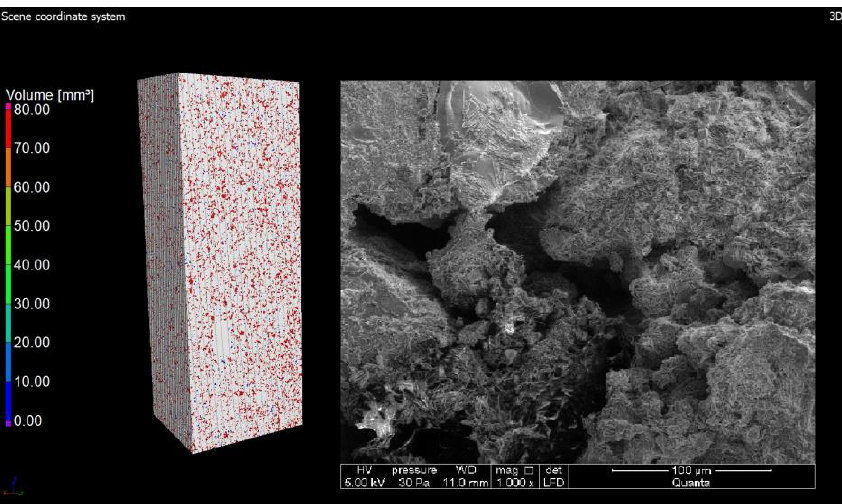
Figure 13. Image of the surface and microstructure of a material modified with glass sand; mag 1000×.